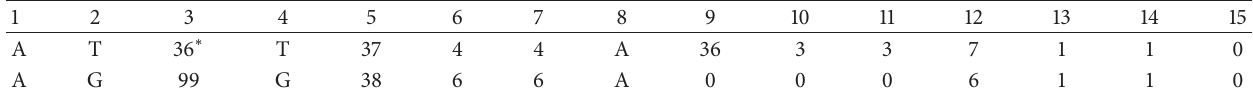
Table 1: Shows two genome positions analyzed by pipeline A (GNUPMap/Soap) as examples of the pipeline processing. The SNP file data analysishas15columns.TheSNPfiledataincludesthefollowing:(1)referencegenotype;(2)consensusgenotype;(3)qualityscoreofconsensus genotype; (4) best base; (5) average quality score of best base; (6) count of uniquely mapped best base; (7) count of all mapped best base; (8)